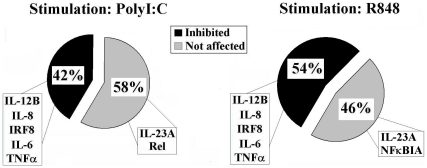
Graphical representation of gene expression modulation by Src kinases inhibition.Human MoDC were pretreated or not with PP2 (20 µM), stimulated with PolyI∶C (20 µg/ml) or R848 (10 µM) for 4 hours, and gene expression was assessed by Microarrays. Inhibition of gene expression by PP2 treatment was analyzed on genes which were up-regulated at least 4-fold upon stimulation, with a p value <0.05.